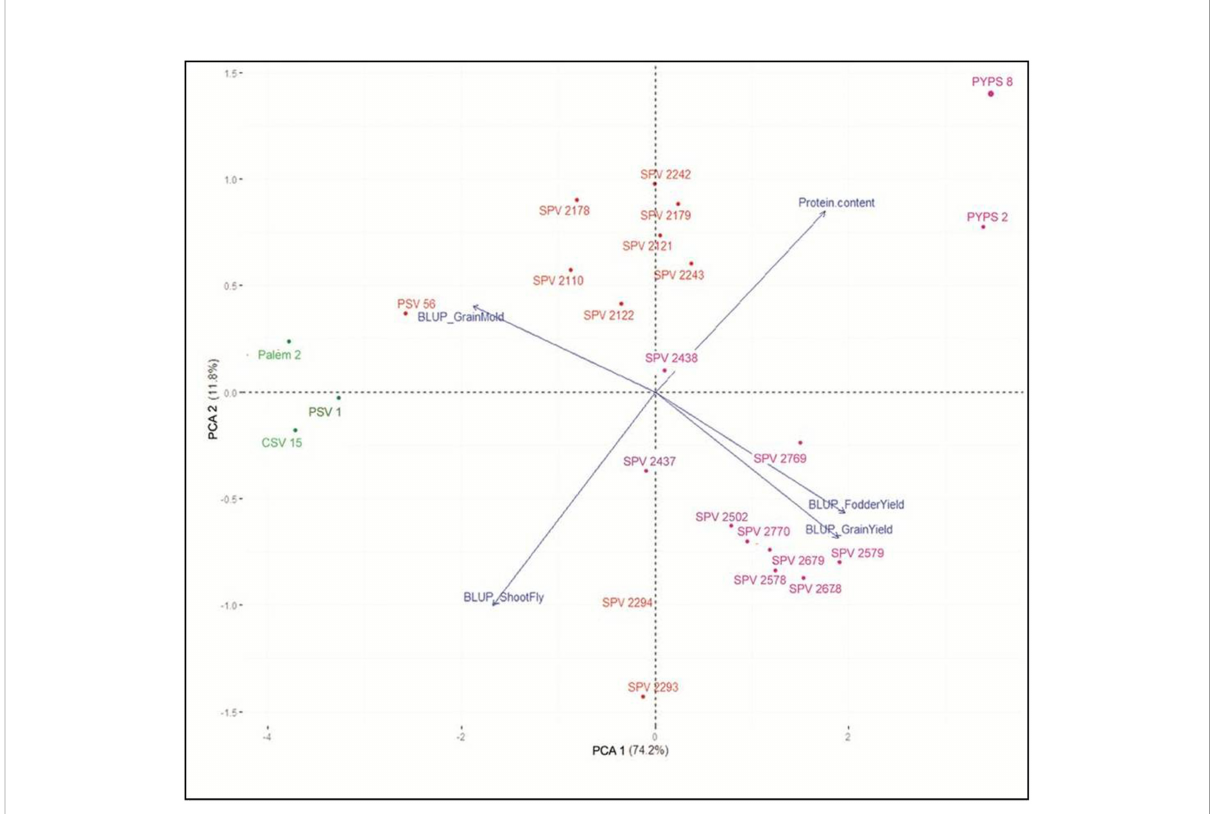
FIGURE 2 Biplot of the fi rst and second principal components based on the best linear unbiased predictor (BLUPs) for grain yield, fodder yield, grain mold score and shoot fl y damage (%) and protein content for a total of 24 sorghum varieties. Data points in green indicate varieties developed before 2005 (pre-2005), red indicate those developed during 2005-2015 and purple indicate varieties developed after 2015